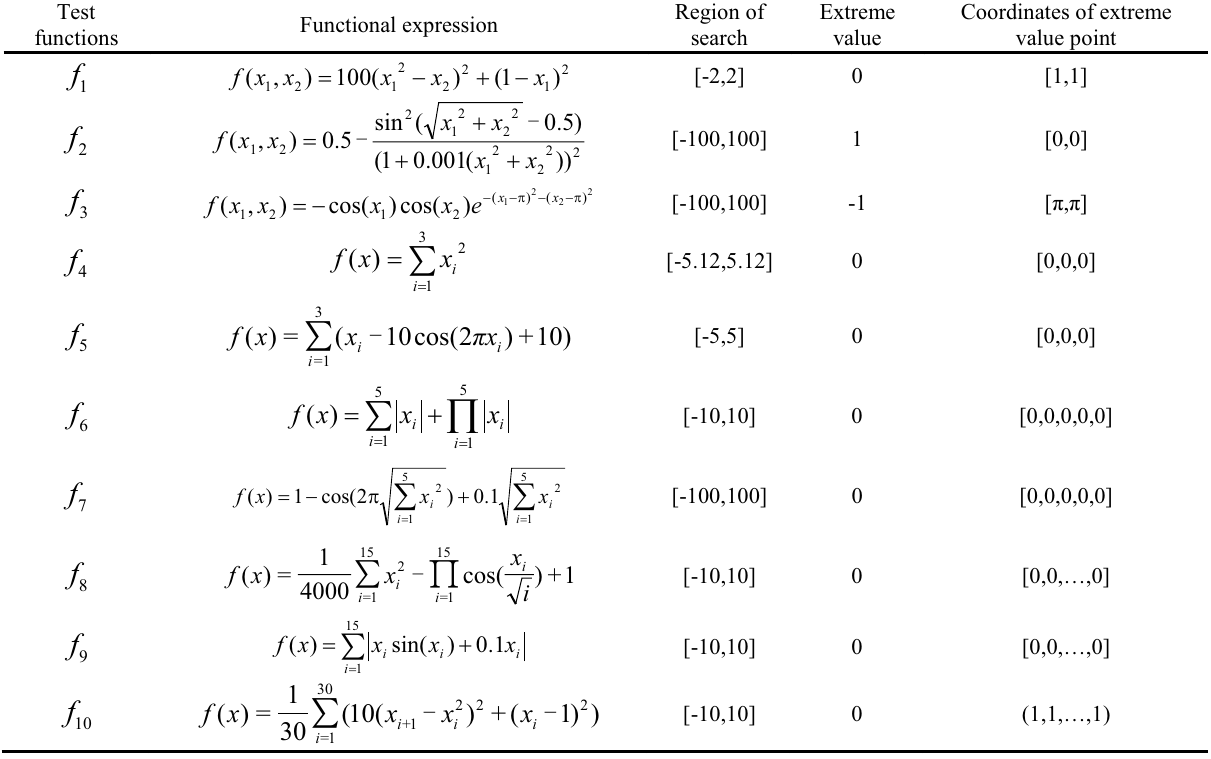
Table1. List of benchmark functions